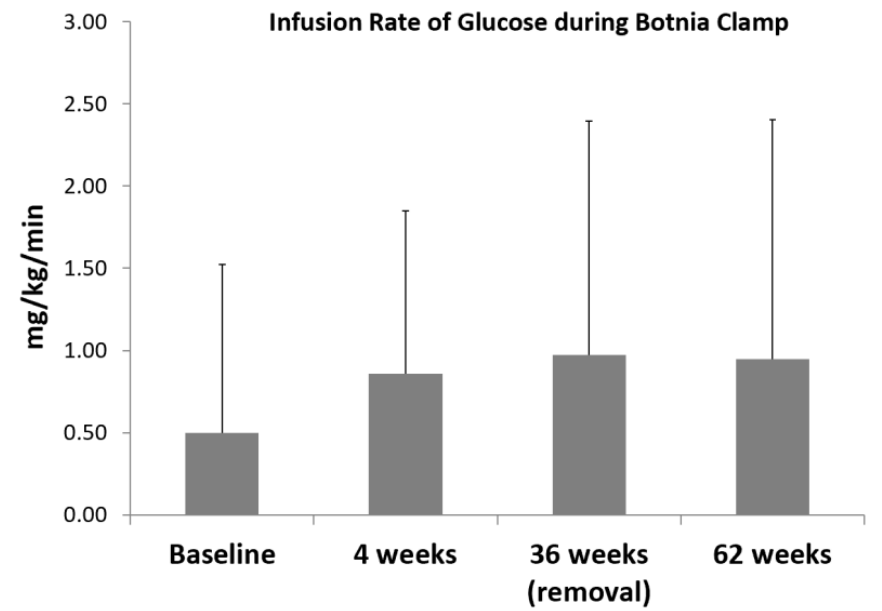
Figure 1. Infusion rate of glucose during 4 Botnia clamp investigations; data are mean ± SD, Base- line vs. 4 weeks p = 0.038; Baseline vs. 36 weeks; p = 0.001; Baseline vs. 24 weeks after explantation p = 0.001.